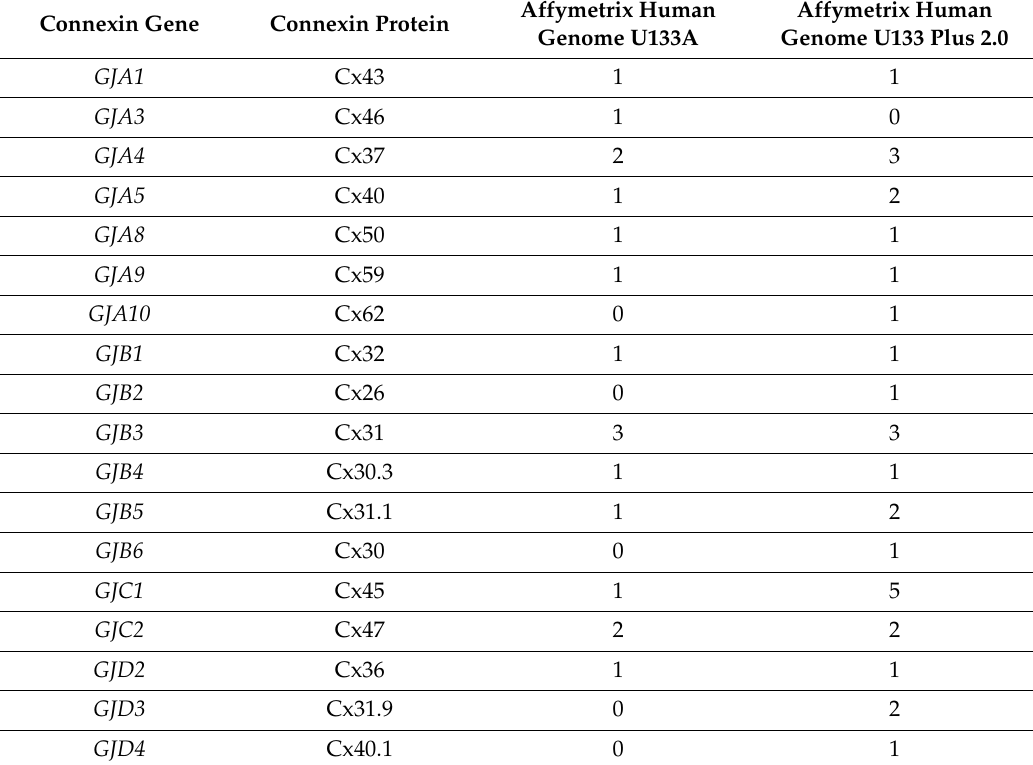
Table 2. Number of probes for connexin genes in Affymetrix Human Genome arrays